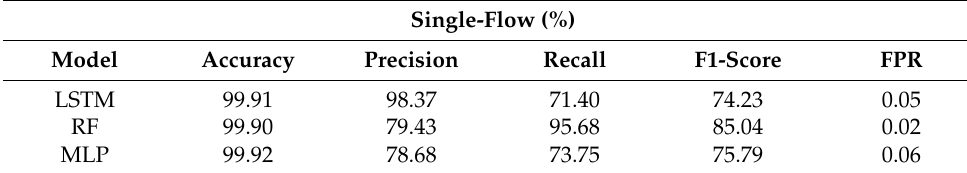
Table 9. Single-Flow results for the LSTM, RF and MLP